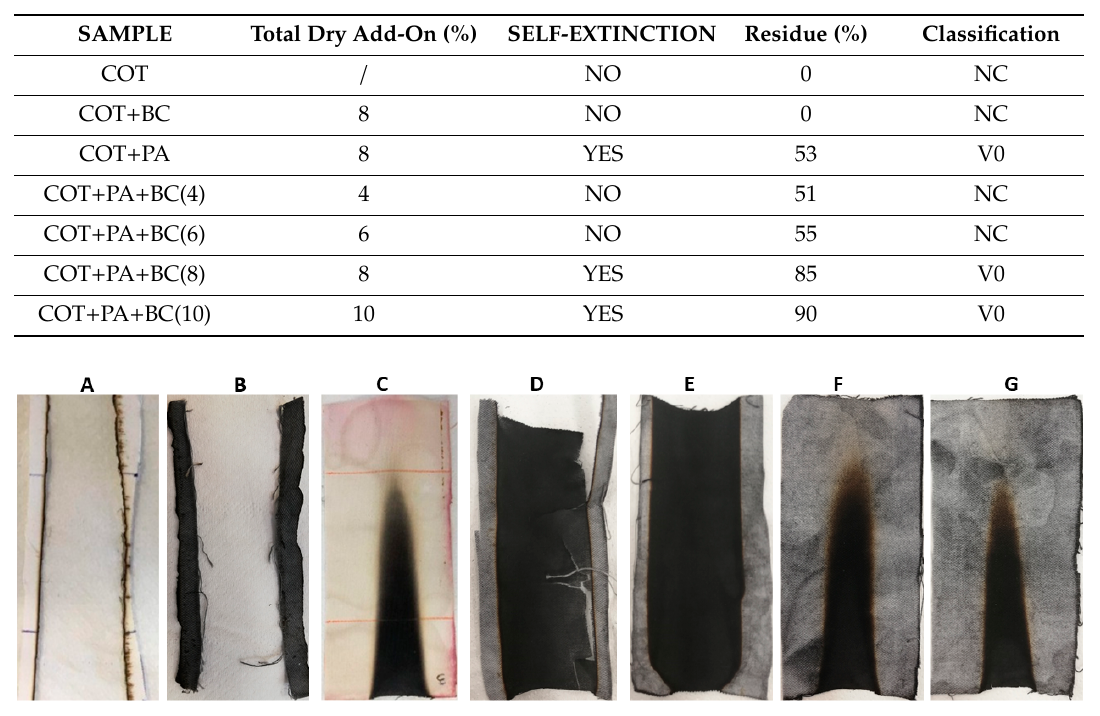
Figure 5. Residues after vertical flame spread tests. A. COT, B. COT+BC, C. COT+PA, D.